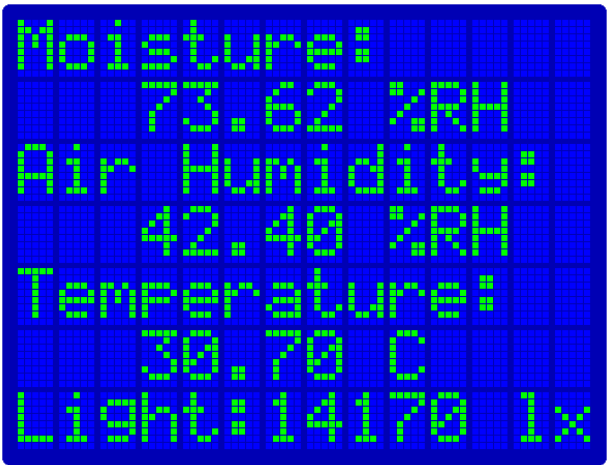
Figure 10. The plant monitoring system screen for local inspection.